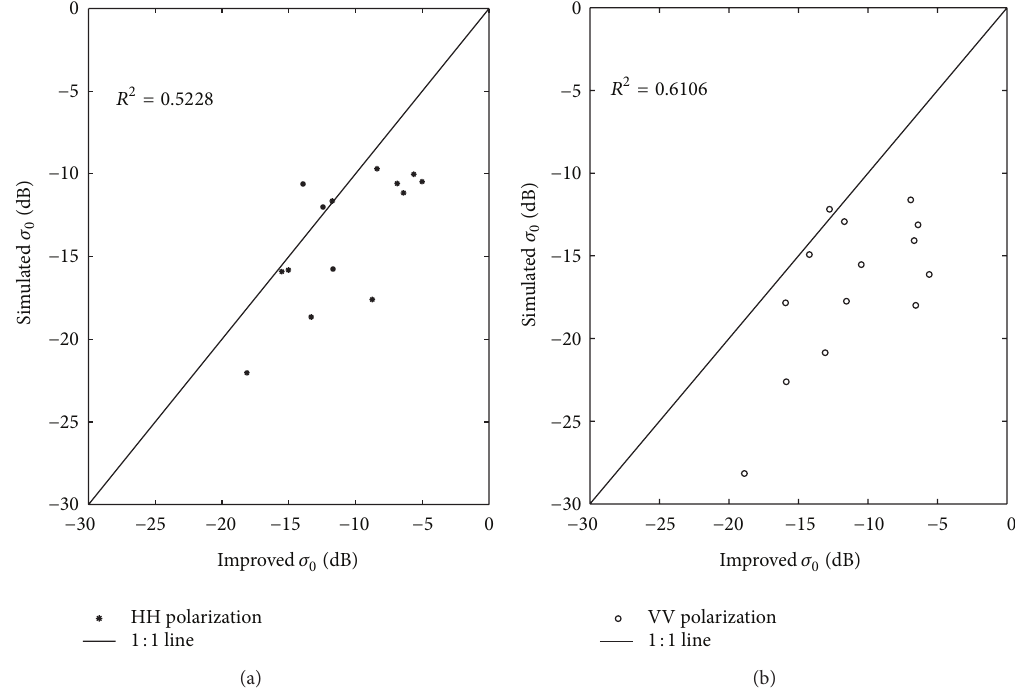
Figure 12: The improved backscattering coefficient from the water-cloud model compared with the simulated backscattering coefficient of the 16 ground samples, with HH polarization on (a) and VV polarization on